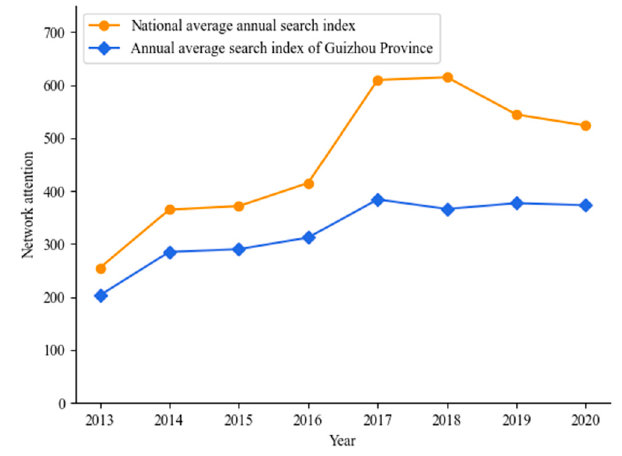
Figure 1. Evolution trend of network attention of “AI + education” from 2013 to 2020.